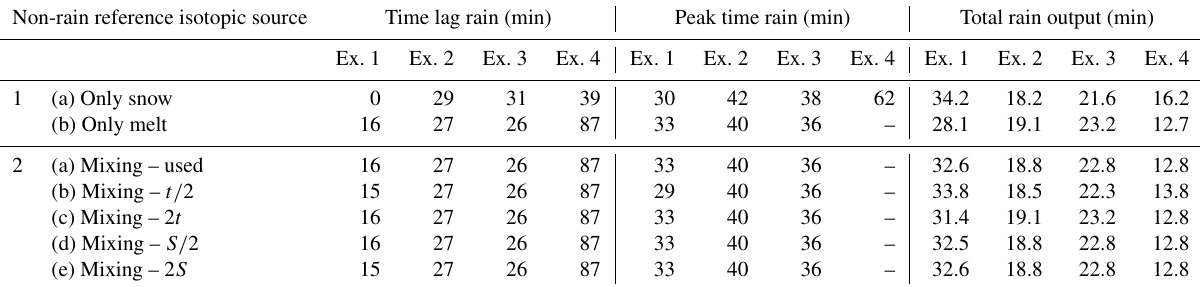
Table 5. Different methods for estimation of reference non-rain water isotopic value were used. 1: constant value of (a) entire snow sample, (b) pre-experimental meltwater. 2: different parameters t and S in Eq. (4), where (a) is parameter used from Table 2; (b) is modified parameter from Table 2; t = t/ 2, S = S ; (c) is modified parameter from Table 2; t = 2 t , S = S ; (d) is modified parameter from Table 2; t = t , S/ 2 = S ; (e) is modified parameter from Table 2; t = t , S = 2 S